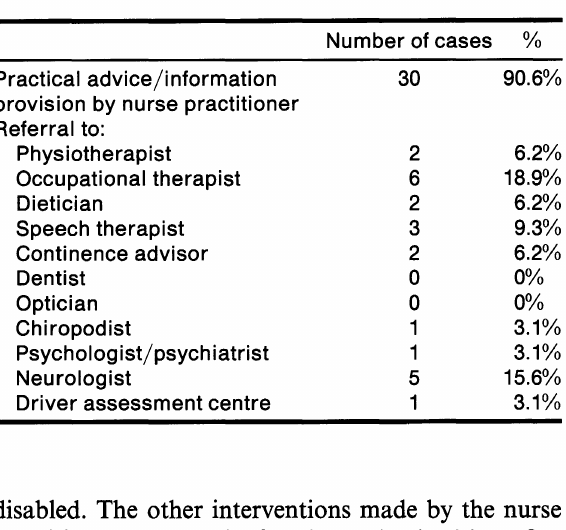
TABLE III. Practical outcome of nurse practitioner